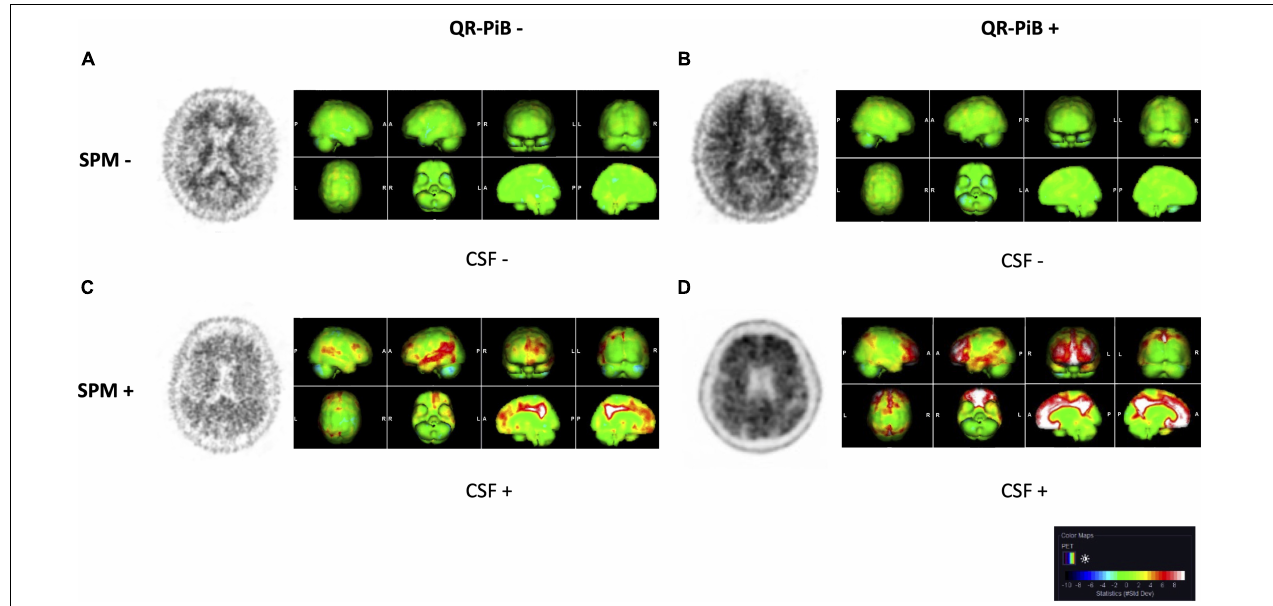
FIGURE 2 | QR-PiB and SPM projections for four cases from the test cohort that represent the spectrum of cases seen in our study. Rows represent SPM − and SPM + cases, and columns represent QR-PiB − and QR-PiB + cases. The CSF A β 42 biomarker status of each case is listed below the SSP. (A) A QR-PiB − , SPM − , CSF − subject (69 y/o, M, MMSE: 29, APOE ε 4 − , t-tau = 470 pg/mL, p-tau = 76 pg/mL, A β 42 = 942 pg/mL). (B) A QR-PiB + , SPM − , CSF − subject (58 y/o, F, MMSE: 30, APOE ε 4 − , t-tau = 295 pg/mL, p-tau = 59 pg/mL, A β 42 = 1,090 pg/mL). (C) A QR-PiB − , SPM + , CSF + subject (73 y/o, M, MMSE: 30, APOE ε 4 + , t-tau = 236 pg/mL, p-tau = 38 pg/mL, A β 42 = 496 pg/mL). (D) A QR-PiB + , SPM + , CSF + subject (76 y/o, F, MMSE: 29, APOE ε 4 + , t-tau = 705 pg/mL, p-tau = 71 pg/mL, A β 42 = 465 pg/mL).